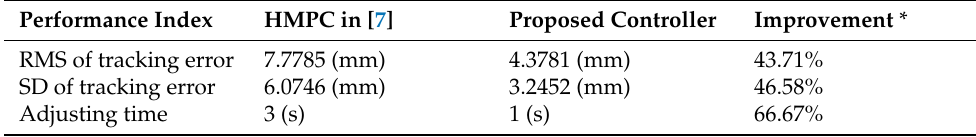
Table 4. Performance index comparison of